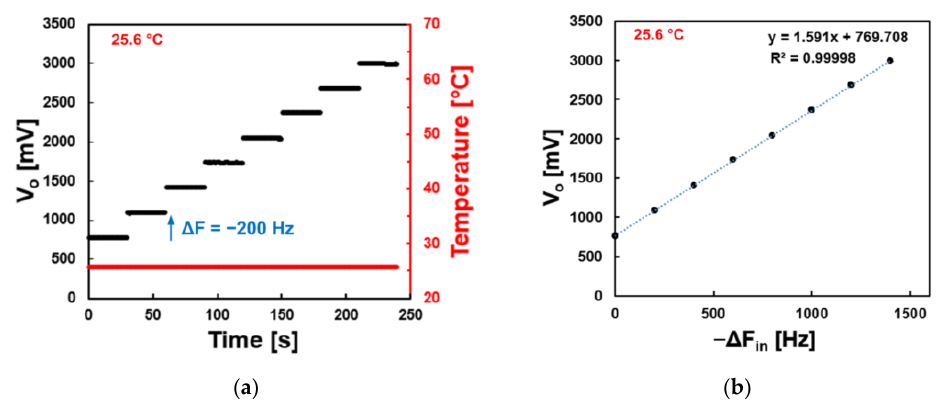
Figure 4. Experiment results for system sensitivity at 25.6 °C: ( a ) measured system output voltages to input frequency changes and ( b ) obtained system sensitivity and linearity.